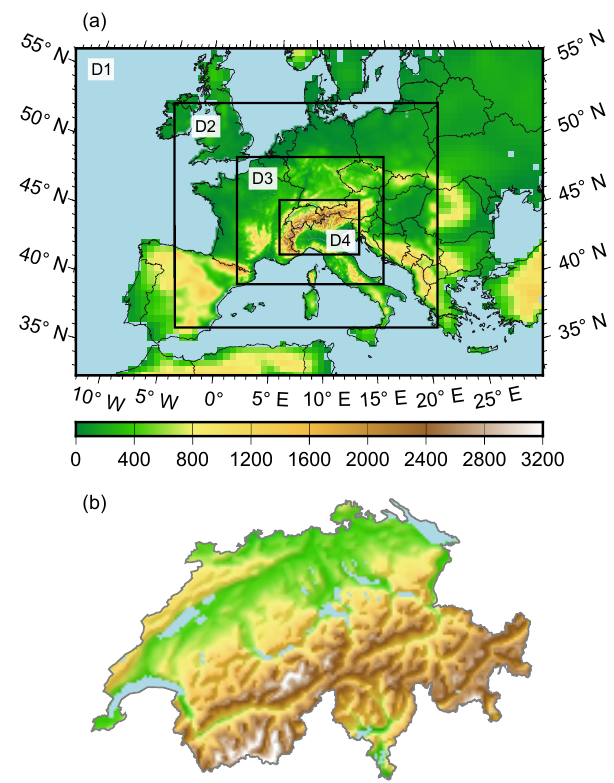
Figure 1. (a) Configuration of the four nested domains used in both the Weather Research and Forecasting model driven by the ERA- Interim reanalysis (WRF-ERA) and by the Community Earth Sys- tem Model (WRF-CESM) simulations. (b) Detail of the actual orog- raphy implemented in the 2km resolution simulation over Switzer-